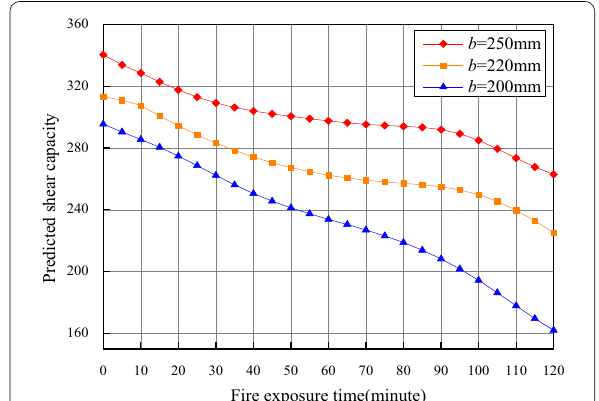
Fig. 8 Effect of beam width b on shear resistance of beams.